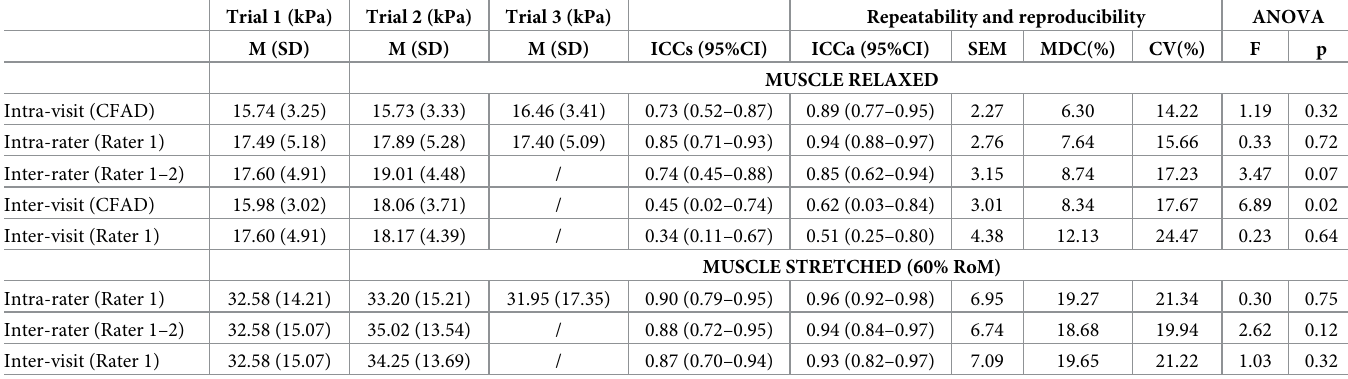
Table 3. Repeatability and reproducibility results for measurements on human participants’ hamstring